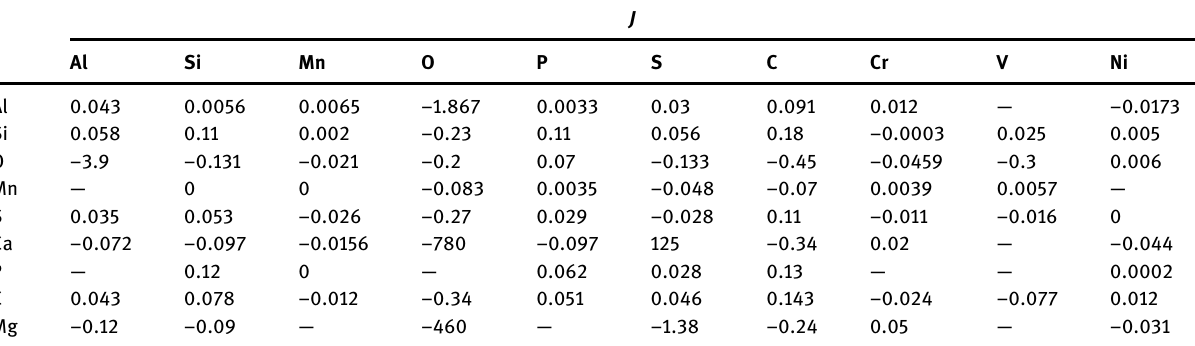
Table 11: The interaction coe ffi cient of each element at 1,873 K [ 29